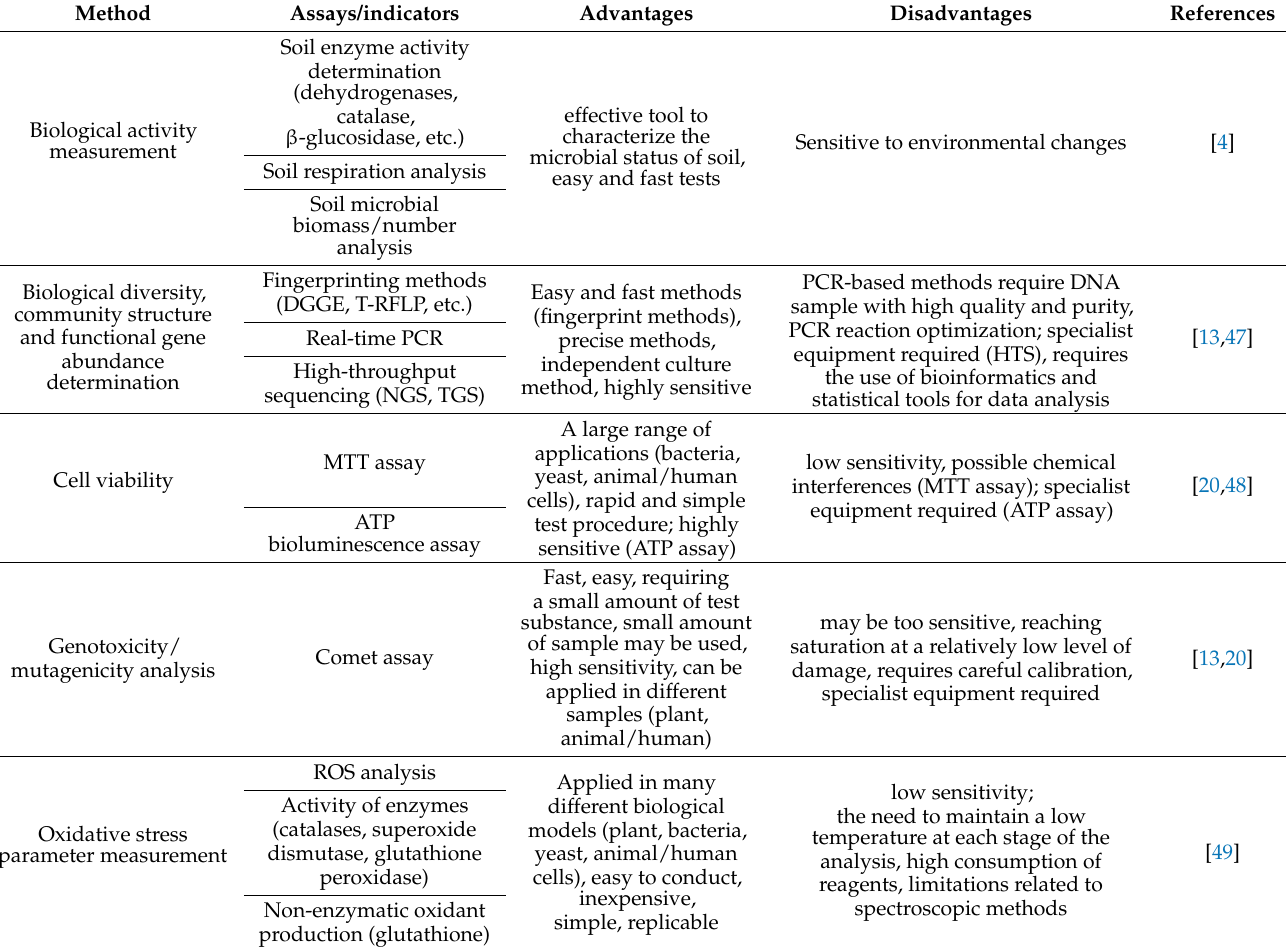
Table 2. Biomonitoring methods used to assess the quality of soil contaminated with